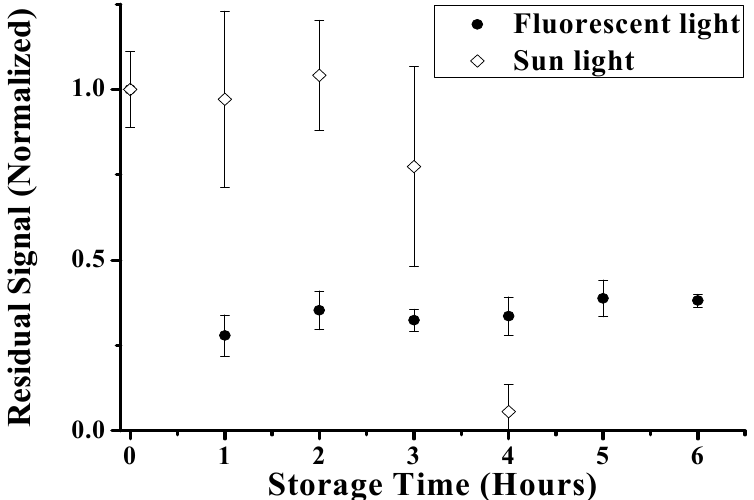
Figure 13. Optical fading behavior of MgB 4 O 7 :Zn glass S35654.